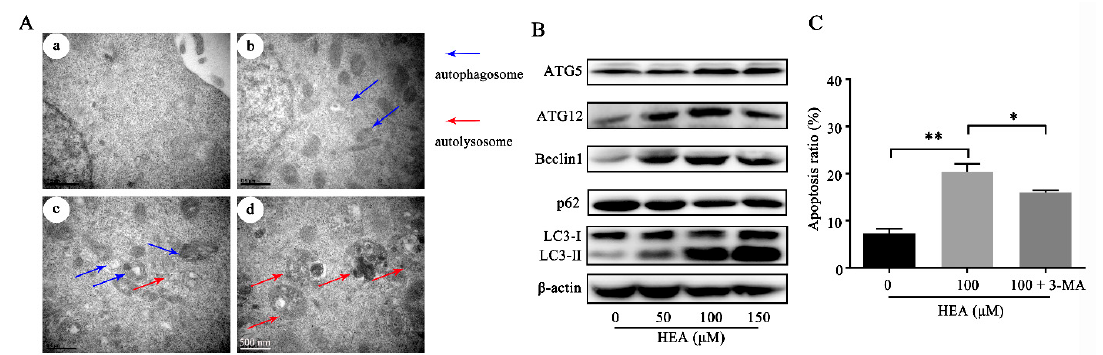
Figure 5. HEA-induced autophagy of SGC-7901 cells. ( A ) Representative TEM for SGC-7901 cells incubated with the following doses of HEA: ( a ) 0, ( b ) 50, ( c ) 100, and ( d ) 150 µ M; blue arrows represent autophagosome, and red arrows represent autolysosome. ( B ) Expression levels of ATG5, ATG12, Beclin1, p62, and LC3 in SGC-7901 cells after treatment with HEA for 48h by immunoblotting. ( C ) Columns for apoptotic SGC-7901 cells incubated with vehicle, HEA (100 µ M), HEA (100 µ M) + 3-MA (5 mM), and autophagy inhibitor 3-MA and HEA had those compounds added 48 h before the apoptosis detection assay. ** p < 0.01, * p < 0.05 compared with 0 µ M HEA group, three repeats per group. 2.6. Inhibition of Tumor Growth by HEA in a Gastric Carcinoma Nude Mouse Model in